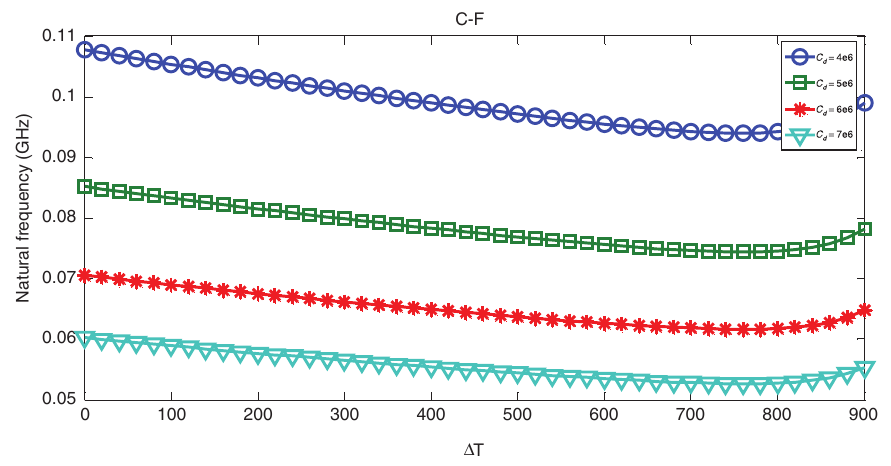
Figure 16: The effect of damping stiffness on the natural frequency with clamped-free boundary condition.